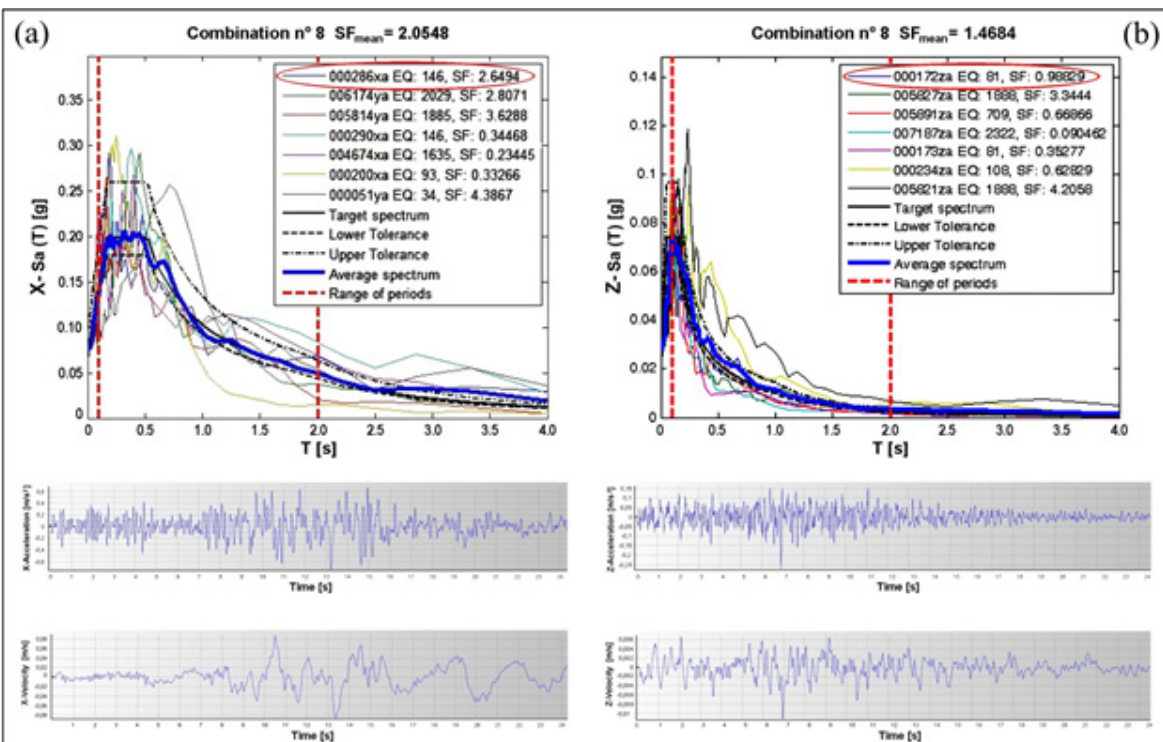
Figure 8: Acceleration–period spectrums of the combinations no 8 and accelerogram/velocity time–history of the two earthquakes chosen (red circled) for the LSR analysis: X-component (a) and Z-component